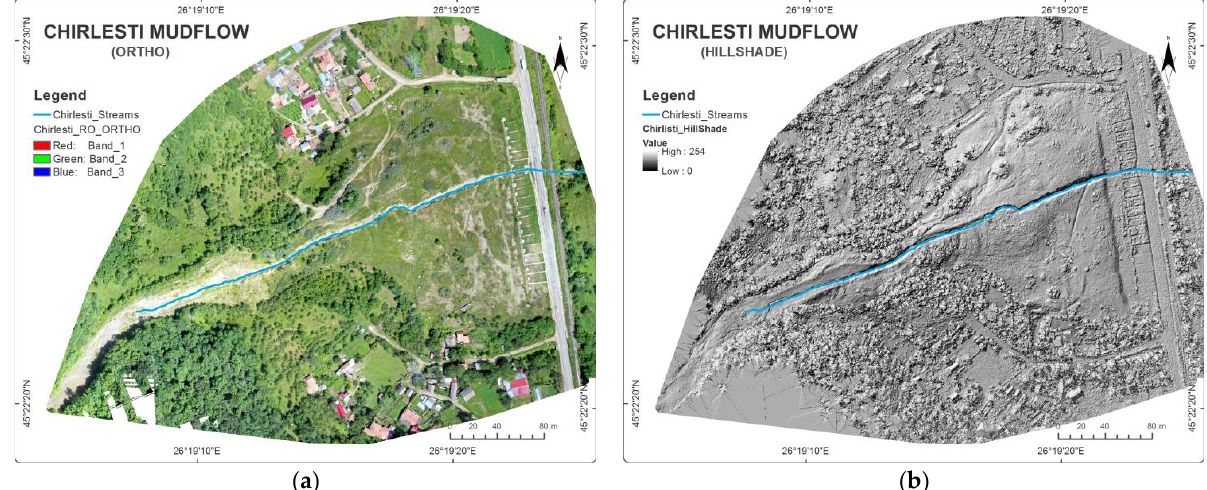
( d ) Figure 6. The case study of Chirlesti Mudflow in Romania captured by the drone flight January 2021: ( a ) orthomosaic; ( b ) hillshade; ( c ) DSM; and ( d ) aspect. ( a )